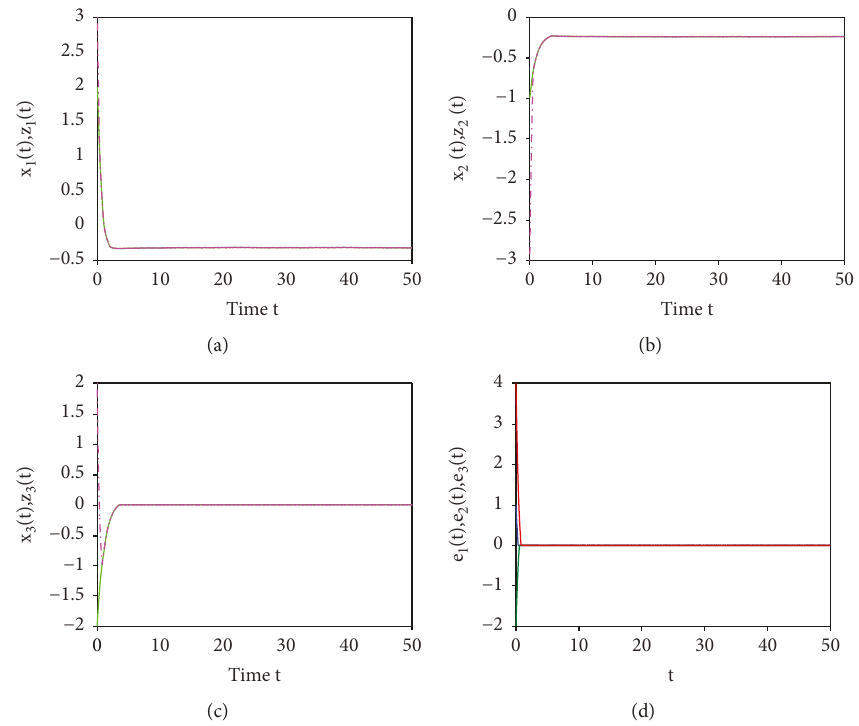
Figure 2: (a – c) The time evolution for the driver network system (35) and corresponding response system. (d) The time response of the synchronization error between the driver system (35) and corresponding response system with the discontinuous